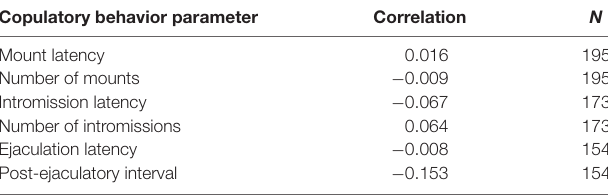
TABLE 3 | Pearson correlations between sexual approach behavior (quantified as a preference score a obtained in the procedure described in Ågmo, 2003) and copulatory behavior in intact male rats having displayed at least one mount or one intromission in a test for copulatory behavior performed immediately after the test for approach